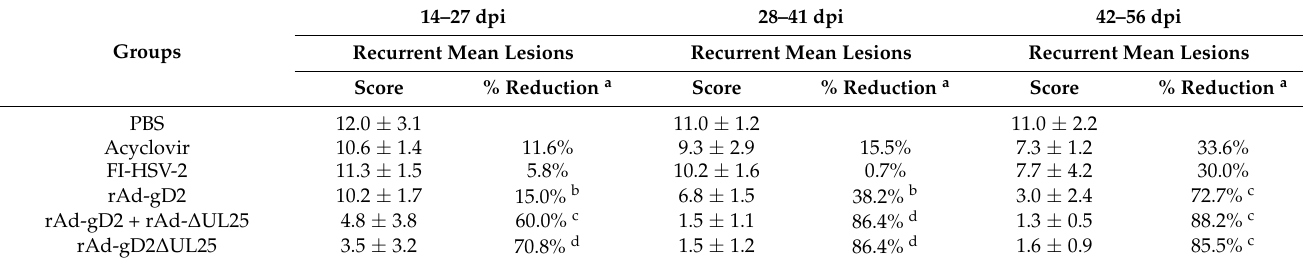
Table 2. Effect of adenovirus vaccines on recurrent lesion score in HSV-2-infected guinea pigs.